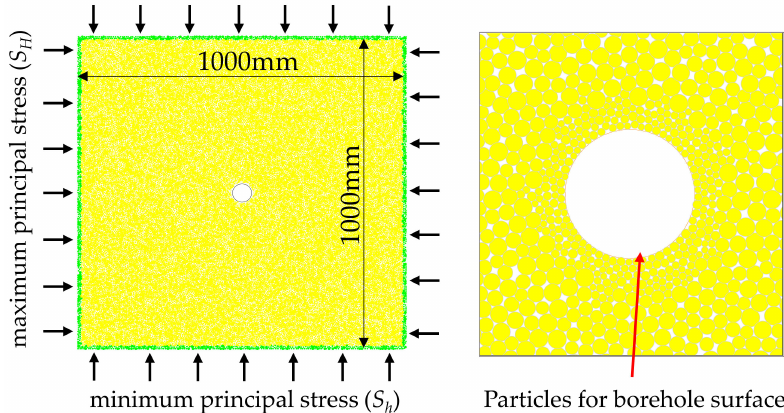
Figure 4. Numerical model for hydraulic fracturing and particle packing method near borehole.